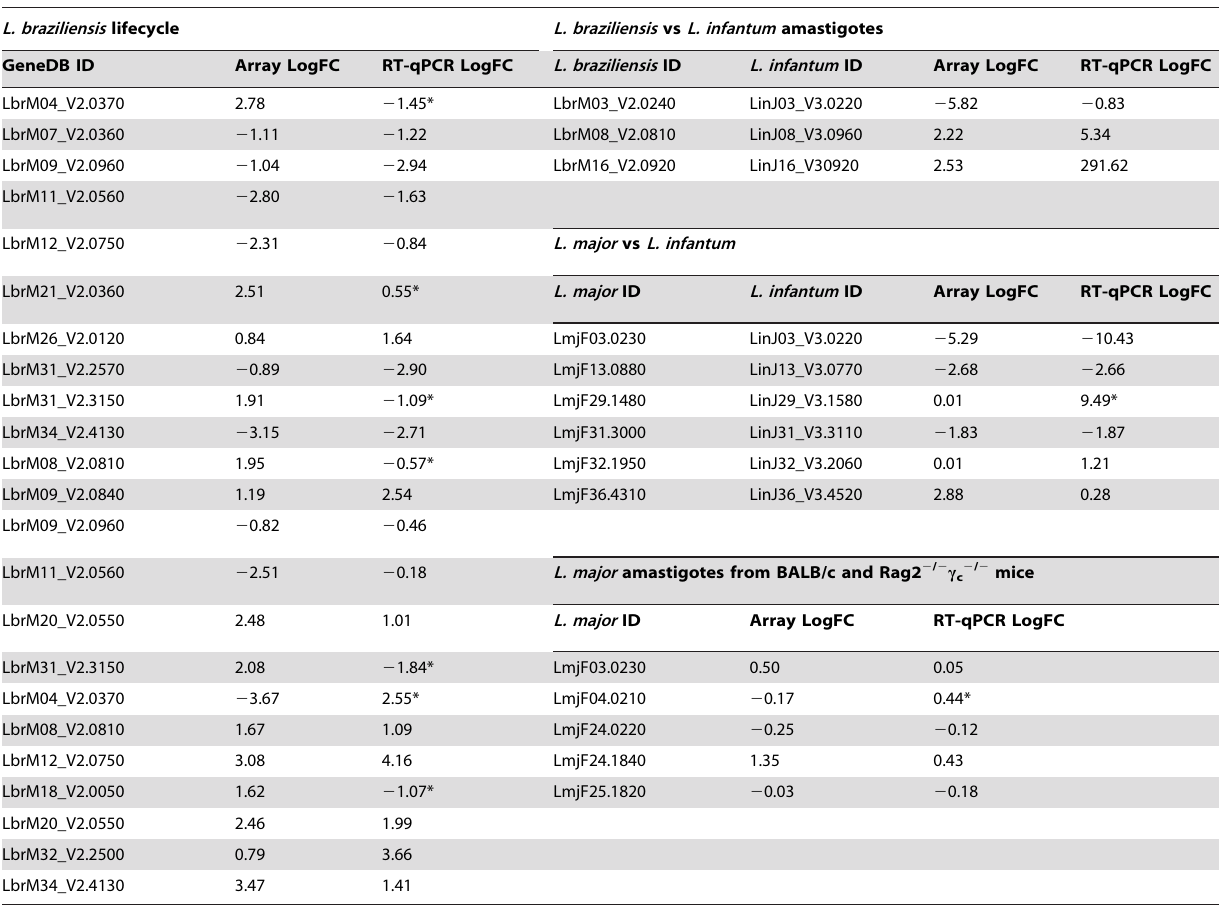
Table 1. Validation of microarray data by quantitative RT-PCR